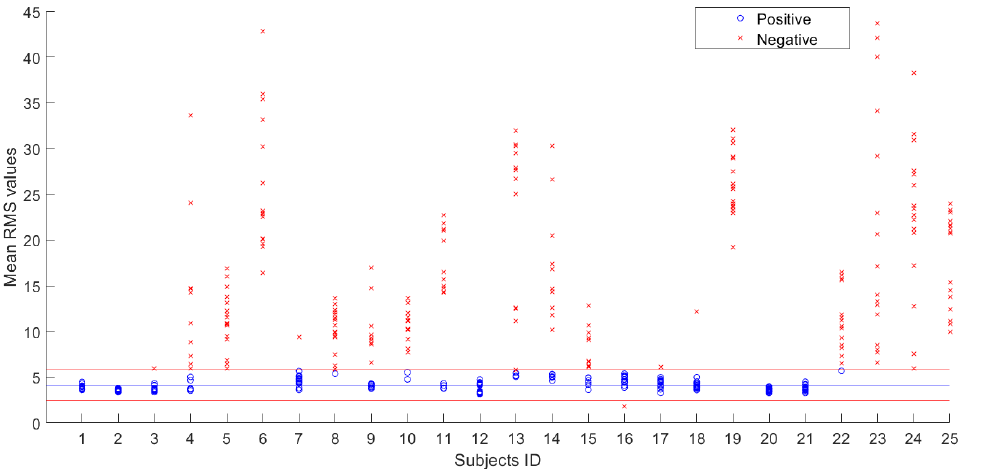
Figure 9. Graphic representation of Tables 1 and 2, related to the last iteration. The blue line is the mean RMS value, while the red lines represent the upper and lower bounds of the FRP validity range. Blue circles are the RMS values that identify FRP presence, while the red crosses are the RMS values that identify FRP absence.